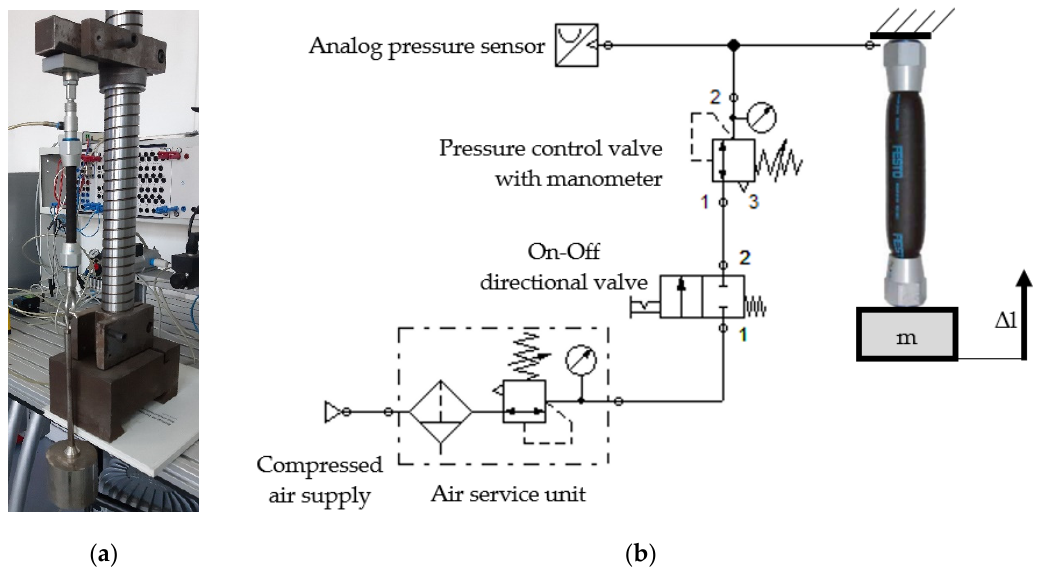
Figure 1. Experimental setup. ( a ) Picture; ( b ) control diagram.